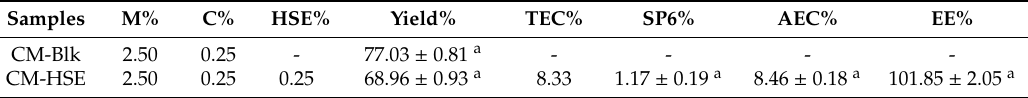
Table 1. Composition and main characteristics of blank (CM-Blk) and hydrolyzed Spirulina extract— (HSE)-loaded particles